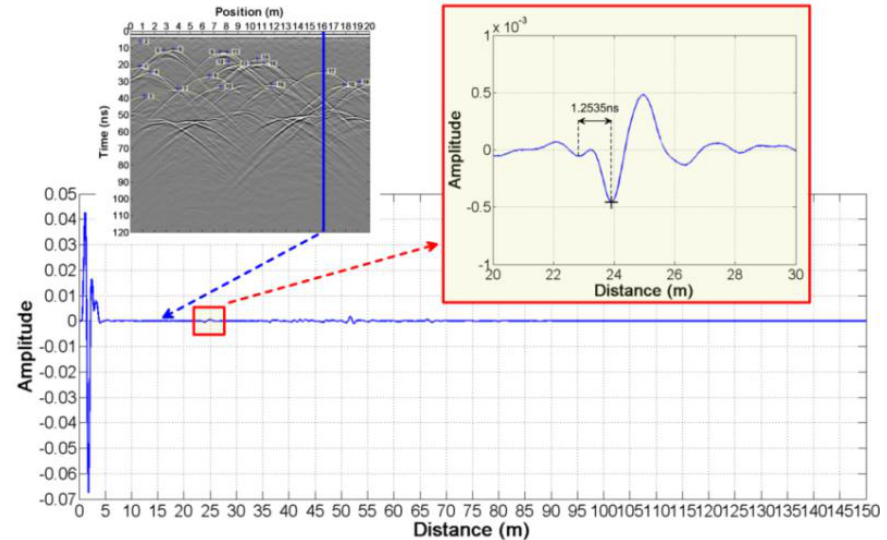
Figure 10. The reflection wavelet waveform of the abnormal body in the complex test model.